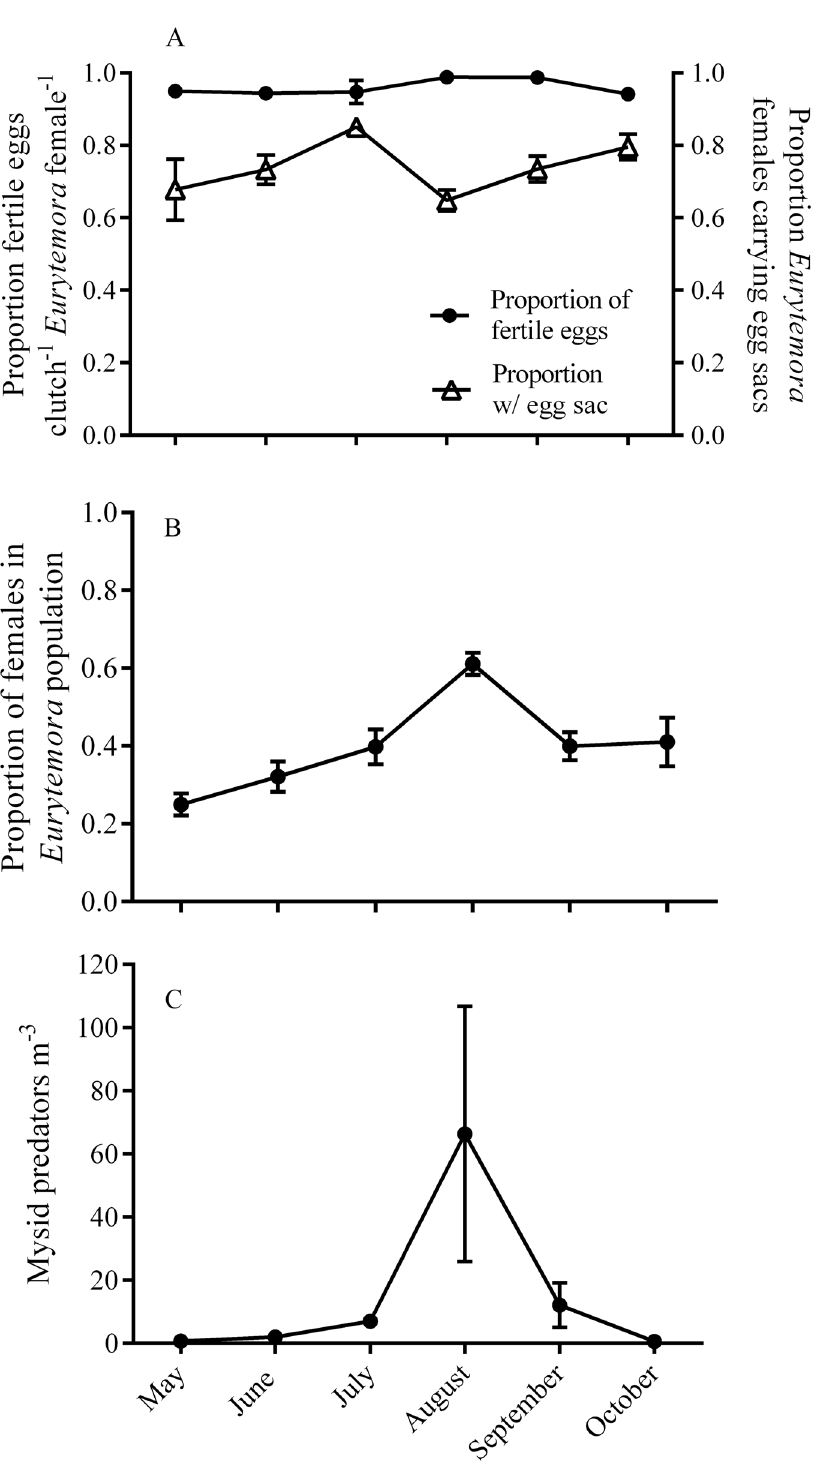
Figure 3. Seasonal dynamics of the (A) fertilization status and ovigery patterns in Eurytemoraherdmani , (B) the proportion of females within the population, and (C) mysid predator abundance from the Damariscotta river estuary in coastal Maine. Zooplankton samples were collected during 5 day field surveys conducted at 3 week intervals from May to October 2008 ( n =30) in coastal Maine. doi:10.1371/journal.pone.0112920.g003 sperm storage [36] such as T. longicornis (and E. herdmani ). fertilization are necessary to determine whether this correlation exist. Future studies addressing the effects of egg production rate on